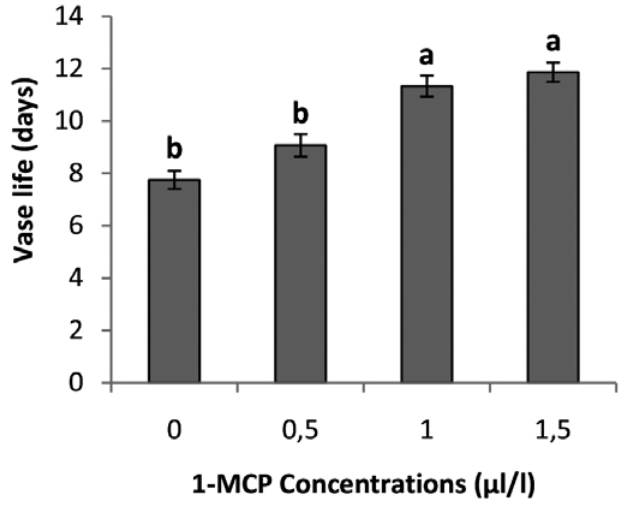
Fig. 1 - Effect of 1-MCP on vase life of carnation cv. Fortune. Data are means with standard errors